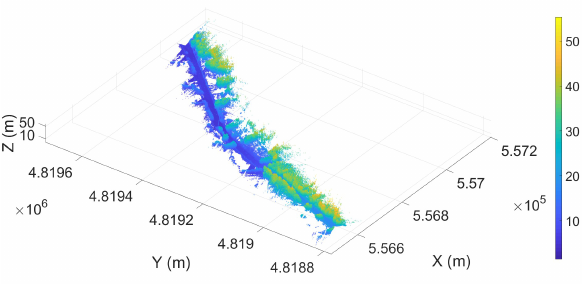
Figure 3. Point Cloud of road DP-36006 used in this